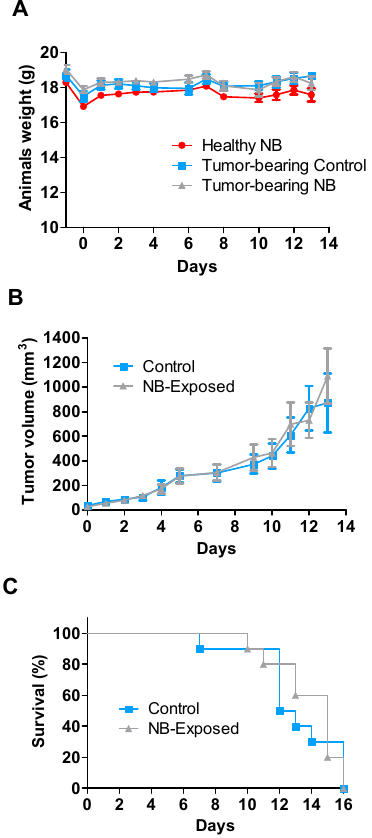
Figure 3. ( A ) Animal growth curves, ( B ) Tumor growth curves, and ( C ) Tumor − bearing animals’ survival plot after animals exposure to narrow − band (NB) signals generated by the TEMPETE narrow-band signal generating system (N = 10 mice/group). Ad ( A ) Healthy animals were weighted two times on the day of HPEM exposure (D0): before and after arriving in the hangar, where field experiments were performed. Ad ( B ) Tumor − bearing animals were exposed 7 days following cancer cells inoculation and were sacrificed when the tumor volume was beyond the limit authorized by the ethics committee.